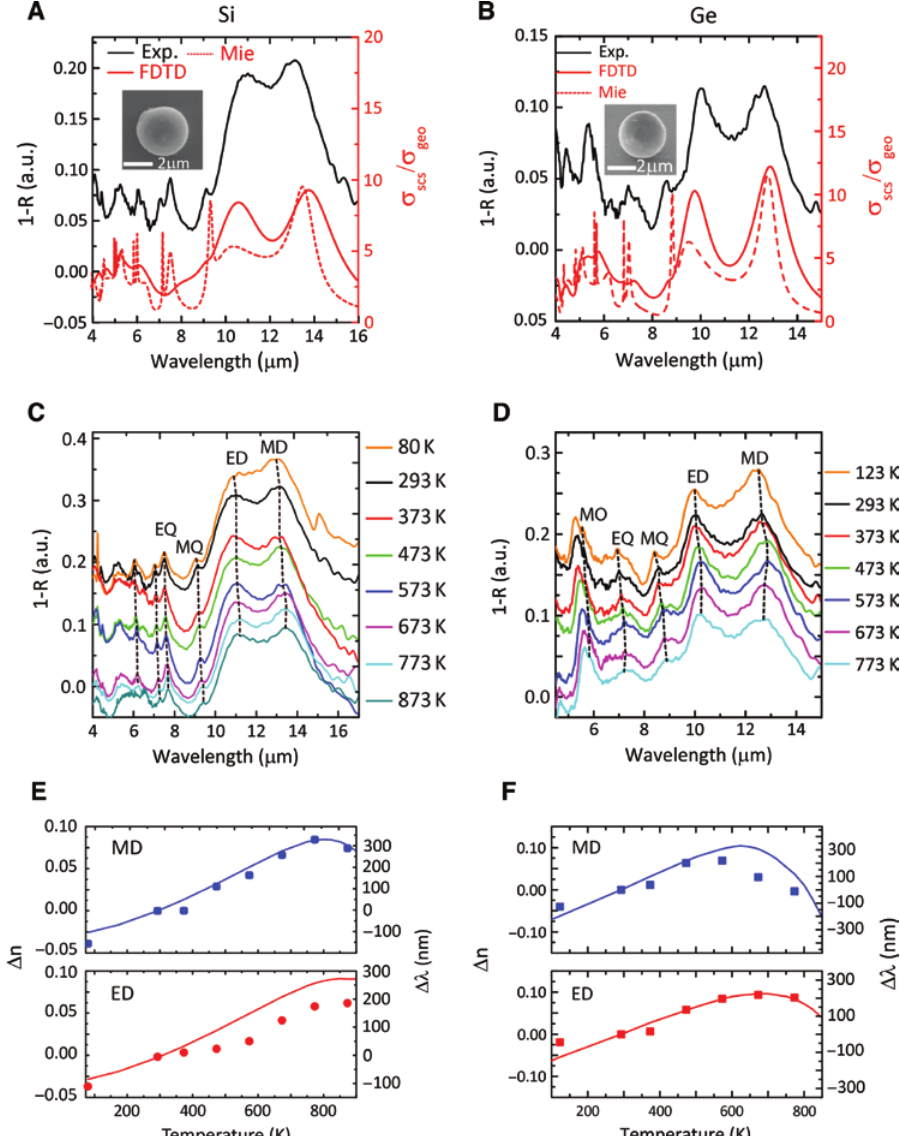
Figure 2: Thermal tunability in single semiconductor meta-atom resonators. (A) and (B) Infrared spectra of Si (a, r = 1.9 μ m) and Ge (b, r = 1.54 μ m) spherical Mie resonators. Experimental spectra show good agreement with the calculated Mie scattering and FDTD cross-sections σ normalized to the geometric cross-section σ . A series of multipolar sca geo resonance peaks are visible in the spectra and correspond to dipole, quadrupole, hexapole, octapole, etc. (C) and (D) Temperature- dependent spectra of the spherical resonators between 80 K and 900 K. The spectral shifts of magnetic and electric dipole (MD and ED) and quadrupole (MQ and EQ) modes are highlighted. The dashed lines track the temperature-dependent resonance peaks and are a guide to the eye. The MO shift is also highlighted in the Ge resonator and is elaborated on in Figure 3. (E) and (F) The extracted induced index and resonance wavelength shifts as a function of temperature for MD and ED modes in Si (E) and Ge (F). Dots are experimentally extracted values, while solid lines are calculated shifts based on Mie